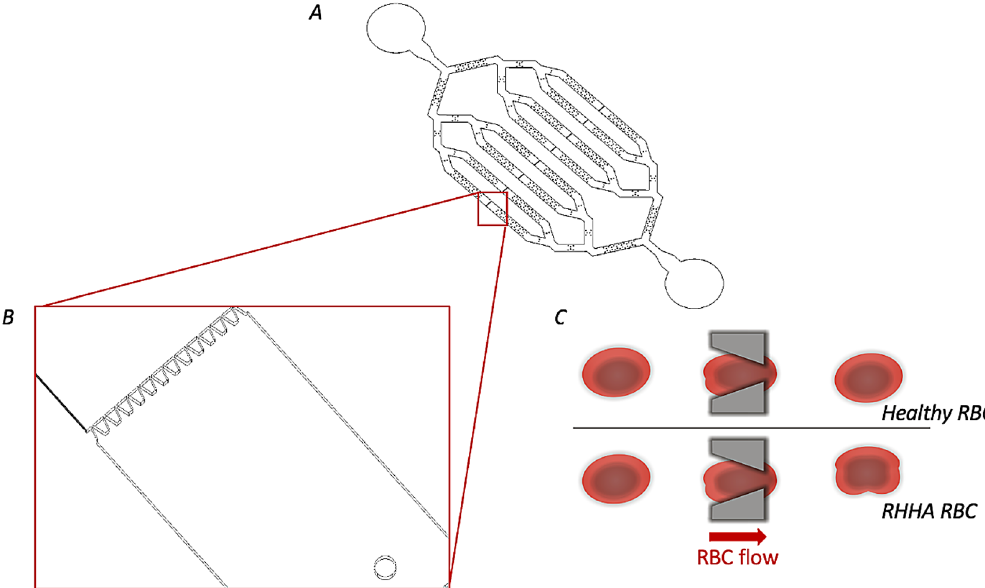
Figure 2. ( A ) Microfluidic unit on a chip designed in the study. It consists of a main channel branched until forming eight parallel microchannels. Each microchannels contain a row of filtering funnel-shaped micro- constriction to mimic the IES section of the spleen. ( B ) zoom out of filtering funnel-shaped constriction. ( C ) Representation of a healthy RBCs and a RHHA RBC passing through the microconstrictions. A healthy RBC deforms its shape and recovers it soon after passed the slits. On the contrary, in a RHHA patient the RBC capacity of returning to the original shape is compromise.